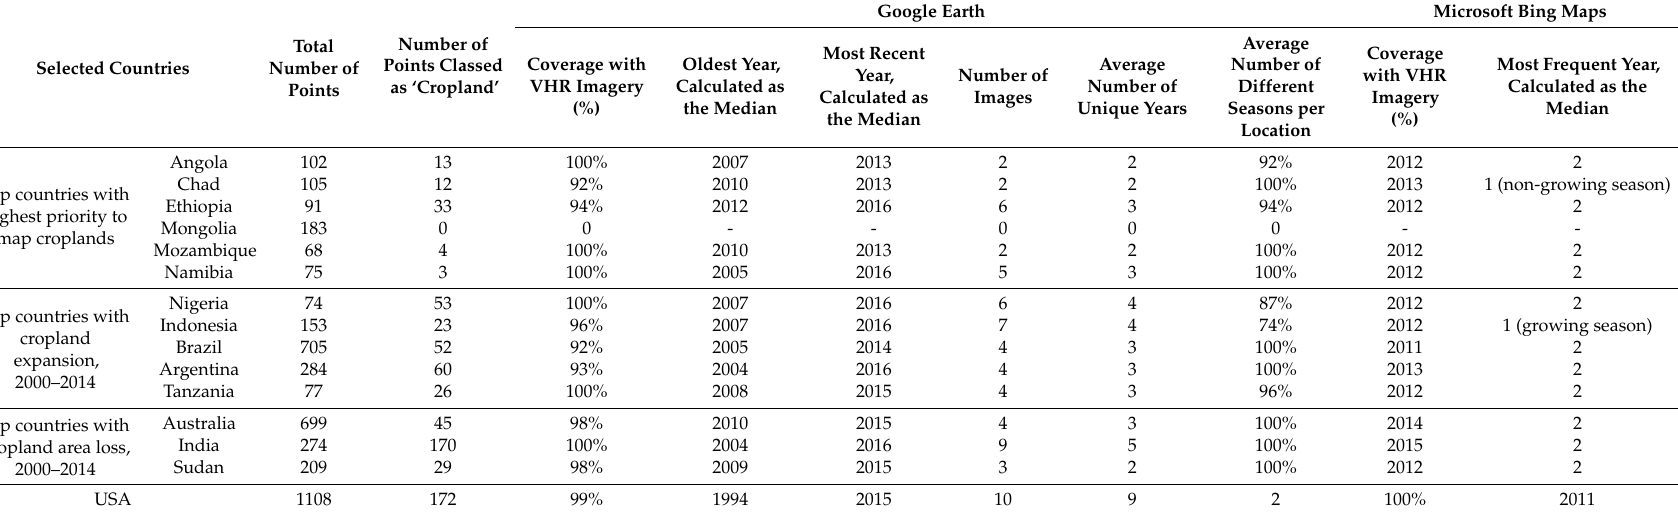
Table 5. Availability of VHR imagery (<5 m) inside cropland areas for selected